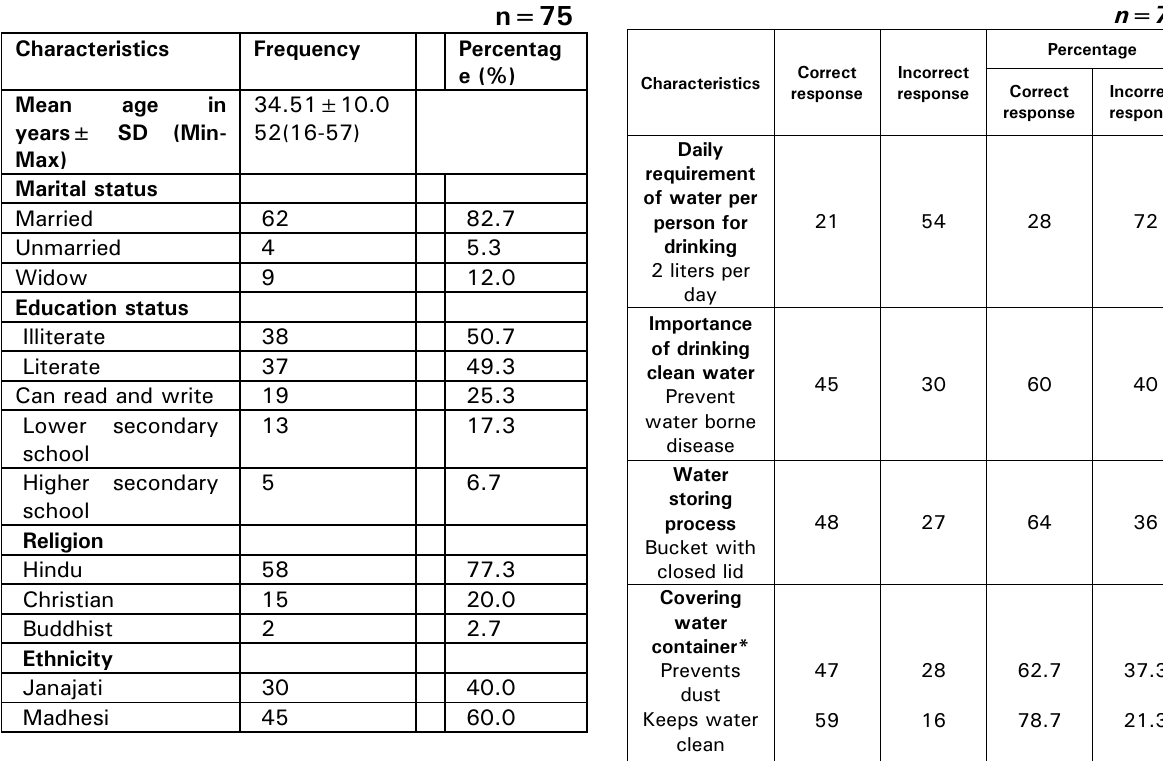
Table 2: Socio Demographic Characteristics of